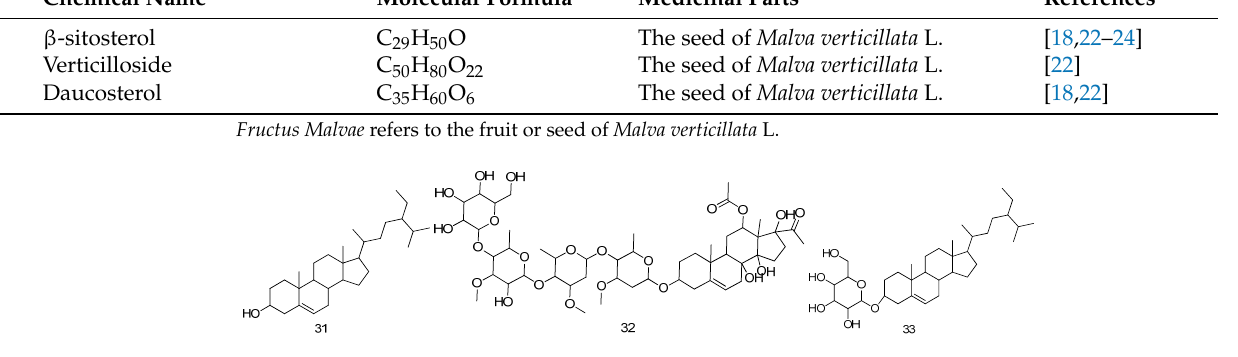
Figure 4. The chemical structures of sterol compounds identified from Fructus Malvae .